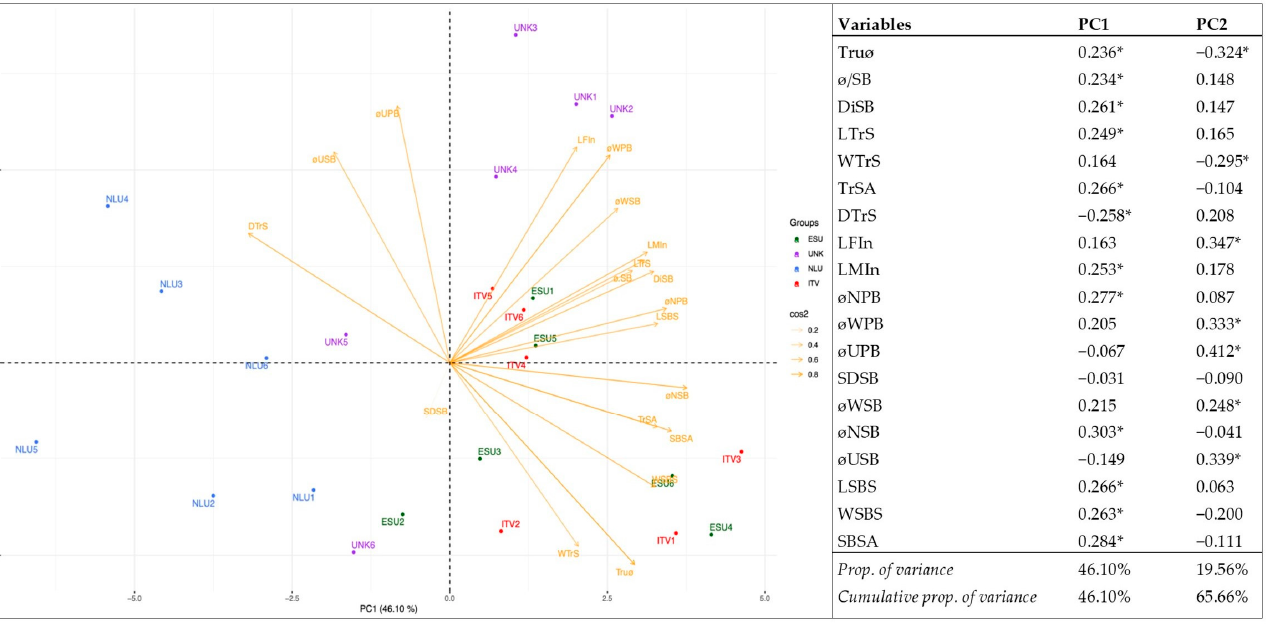
Figure 3. PCA biplot (left) and principal components (PCs) loadings (right). * Variables with component loading used to interpret the PCs: threshold level 0.23.